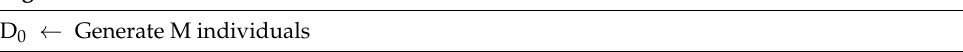
Algorithm 1. RHEDA-TTRP framework